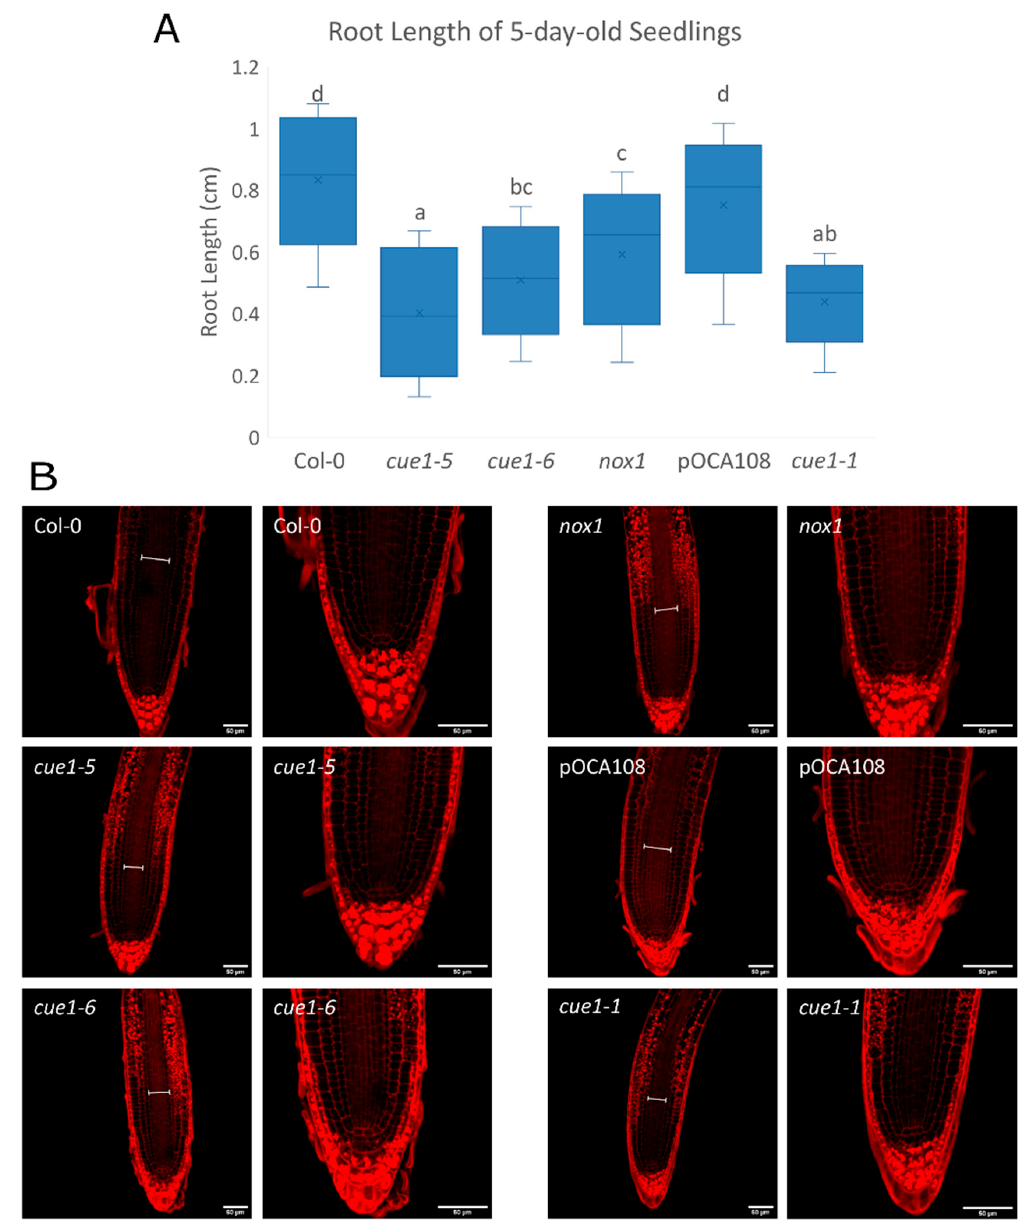
Figure 4. Root elongation is defective in all cue1 mutants. ( A ) Primary root length of 5-day-old seedlings. The diagram shows data between the lower (Q1) and upper (Q3) quartiles, the median and the mean (x) for each genotype. Bars with common letters (a–d) do not show significant statistical differences as determined by one-way ANOVA with post-hoc Tukey’s HSD test (F (5,214) = 57.8, p < 0.001). ( B ) Representative images of the root apex of 5-day-old seedlings stained with Schiff propidium iodide. Scale bars on the bottom right corner correspond to 50 μ m. The width of the vascular bundle is indicated with a white line in each root.